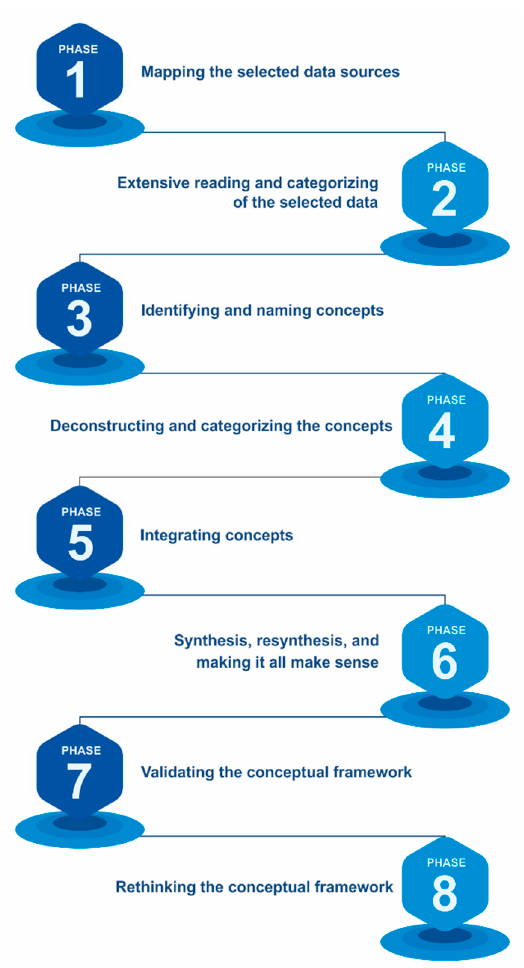
Figure 7. Methodology used to build the proposed conceptual framework [56].